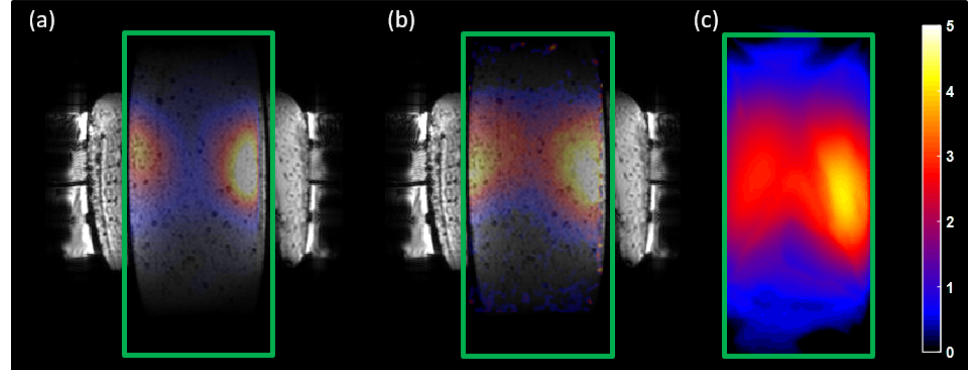
Figure 6. Simulated and measured temperature distributions ( a ) Simulated temperature increase image ( b ) Measured temperature increase with MRT ( c ) Measured temperature increase with IR camera. The green rectangle shows the borders of the